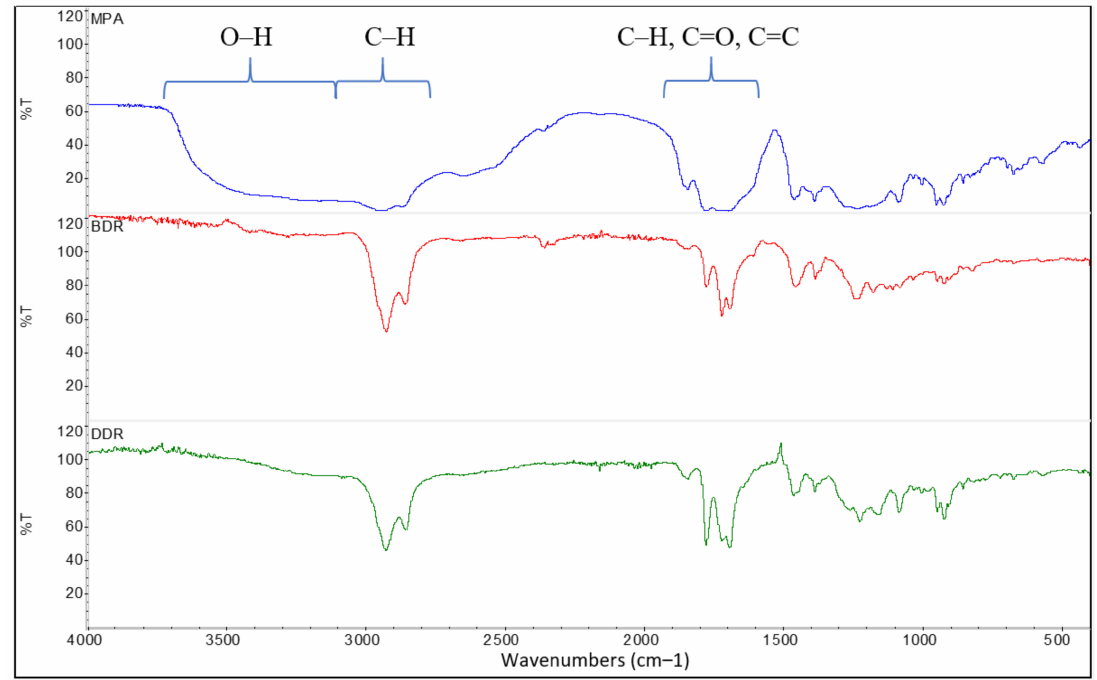
Figure 2. FTIR-ATR spectra of (from the top) MPA, BDR, and DDR.